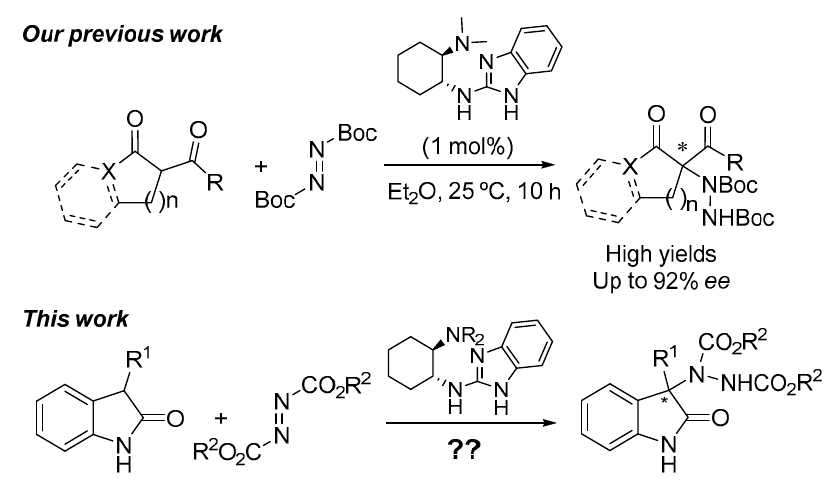
Figure 1. Benzimidazole-based organocatalyst in the asymmetric electrophilic amination of active methylene compounds.